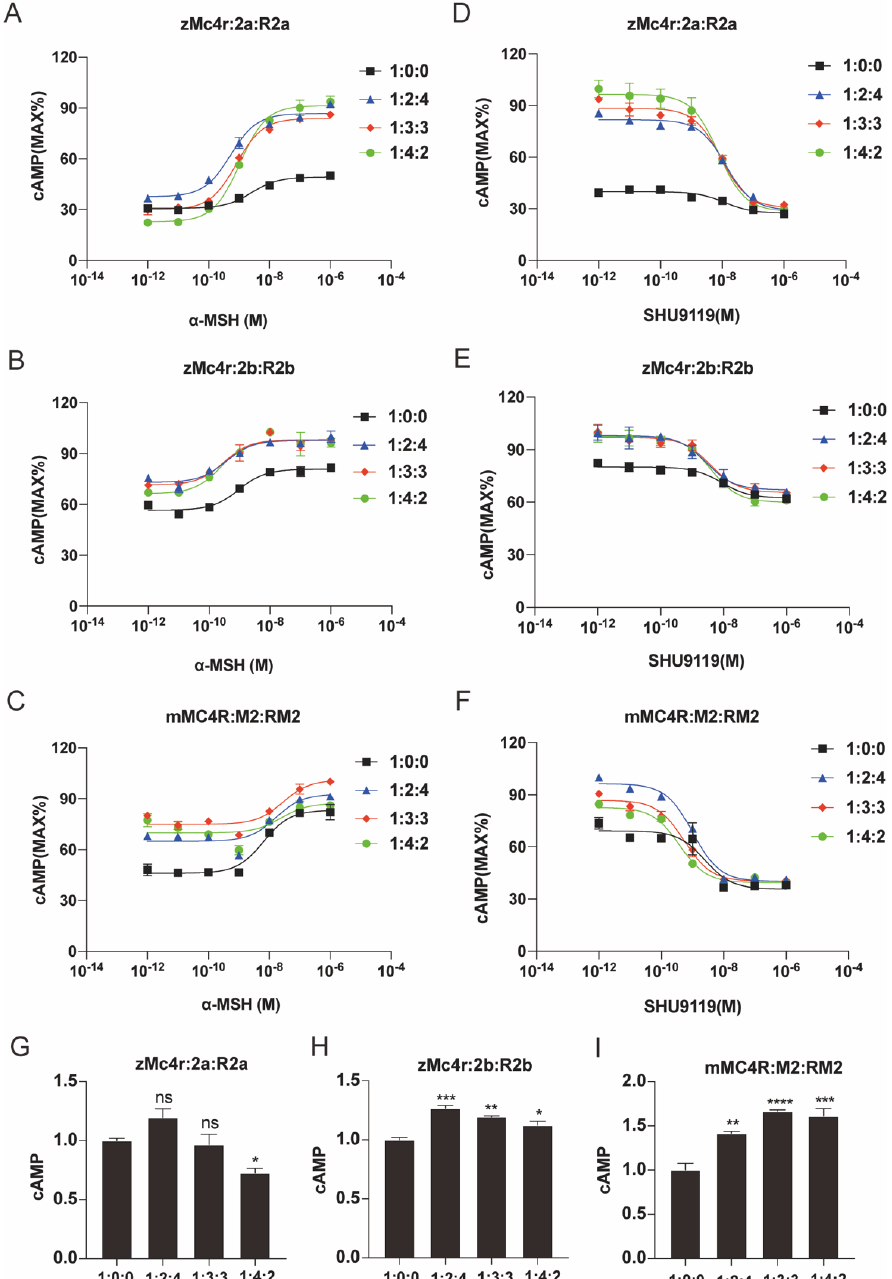
Figure 6. Wild − type and reversed Mrap2a/b differently affect the pharmacological profiles of zMc4r. ( A – C ) Dose − responsive stimulation of MC4R by α− MSH − induced cAMP production with different ratios of wild ‐ type and reversed Mrap2a/b ( A , B ) or MRAP2 ( C ). ( D – F ) Dose − responsive inhibition of MC4R by antagonist SHU9119 with different ratios of wild ‐ type and reversed Mrap2a/b ( D , E ) or MRAP2 ( F ). ( G – I ) The basal cAMP level caused by transfected MC4R, MRAP2 and RMRAP2 in the absence of an agonist. Data were analyzed by one − way ANOVA and shown as mean ± SEM of three replicates. ns (not significant difference), * p < 0.05, ** p < 0.01, *** p < 0.001 and **** p < 0.0001. 2a: Mrap2a, R2a: RMrap2a, 2b: Mrap2b, R2b: RMrap2b, M2: MRAP2, RM2: RMRAP2. Data shown in Table 1 represent the EC50 of dose–response curves in Figures 5 and